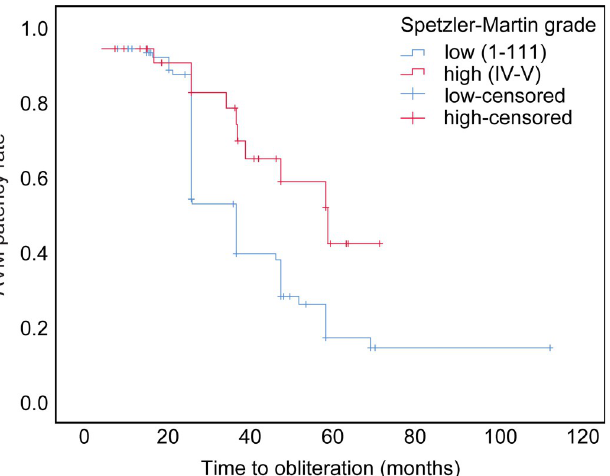
Fig 5. Time to obliteration after CyberKnife radiosurgery in patients with “low-grade” vs. “high-grade” arteriovenous malformation. Kaplan-Meier curve of the time to obliteration (in months) in the subgroups of patients with “low-grade” (Spetzler-Martin grade I–III) vs. “high-grade” (Spetzler-Martin grade IV–V) arteriovenous malformations (AVMs) treated via CyberKnife radiosurgery. The curve shows a significant difference in the times to obliteration between the two groups (p =